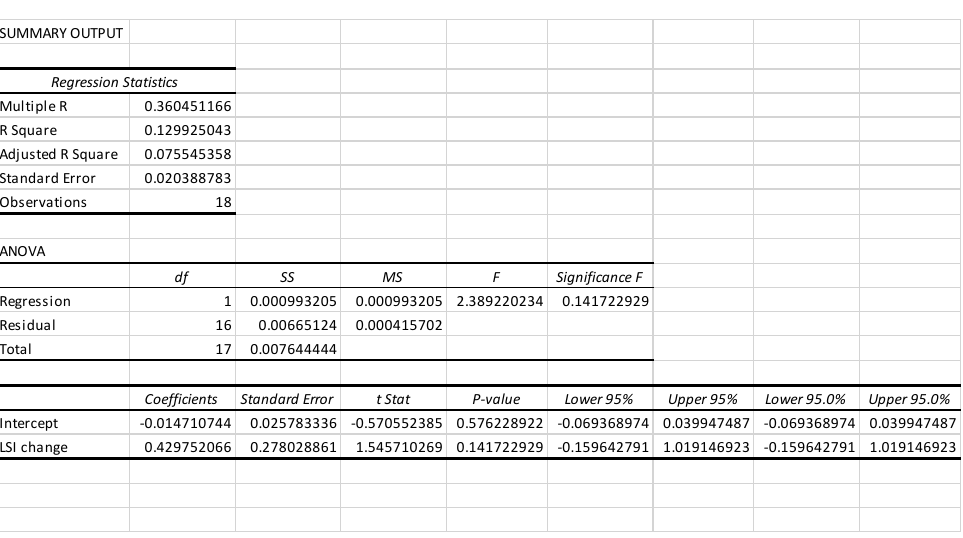
Figure 5. Before — After LSI change and CD/TD ratio per scenario.